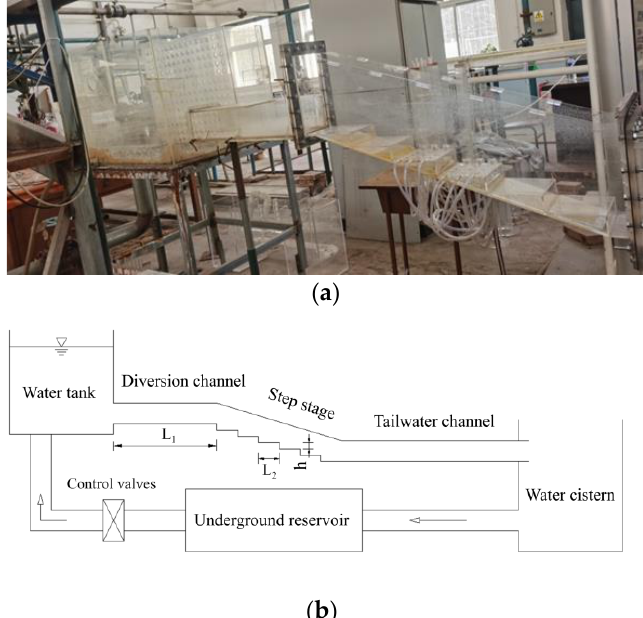
Figure 3. Model experimental setup and profile arrangement: ( a ) experimental model; ( b ) experimental model layout section.